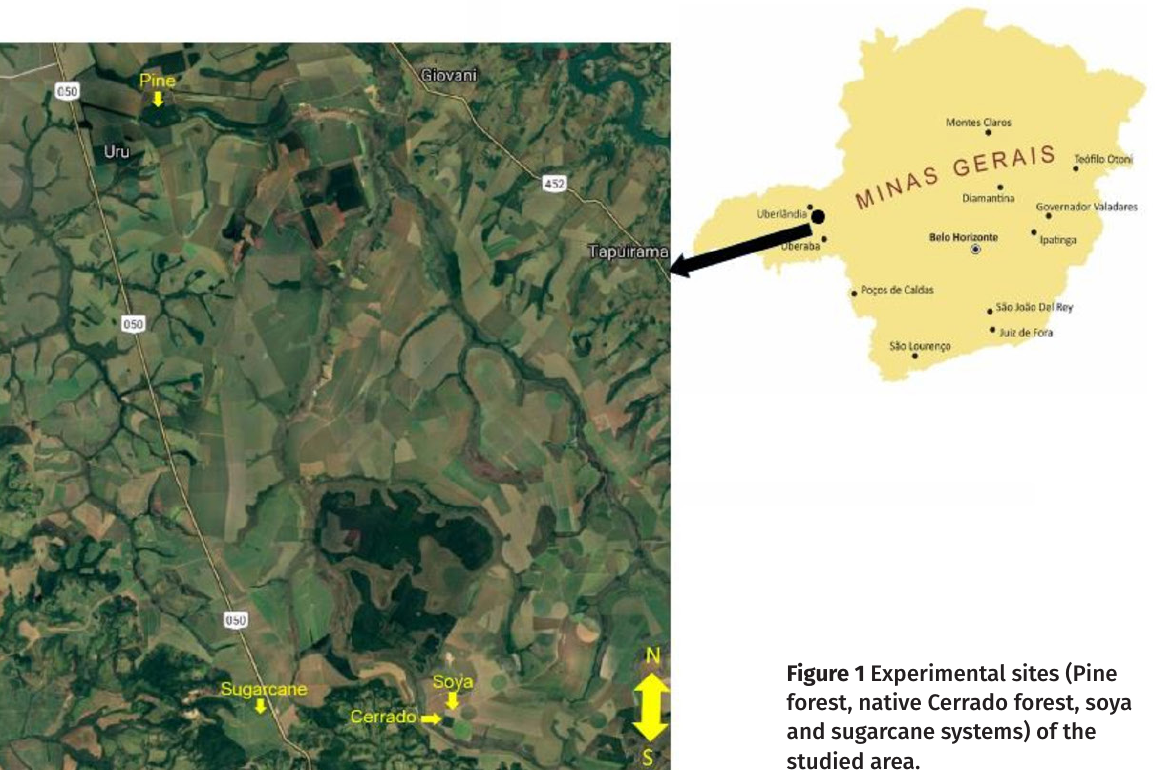
Figure 1 Experimental sites (Pine forest, native Cerrado forest, soya and sugarcane systems) of the studied area.